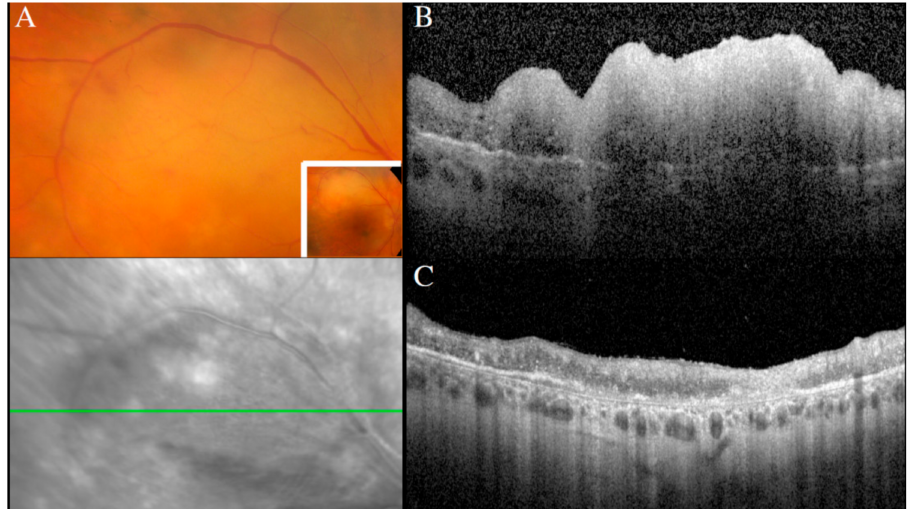
Figure 9. Creamy retinal lesion on a fundus photograph ( A ), corresponding to a large inner retinal infiltrate on a SD-OCT scan ( B ). Regression of the retinal lesion after intravitreal methotrexate, with residual retinal atrophy ( C